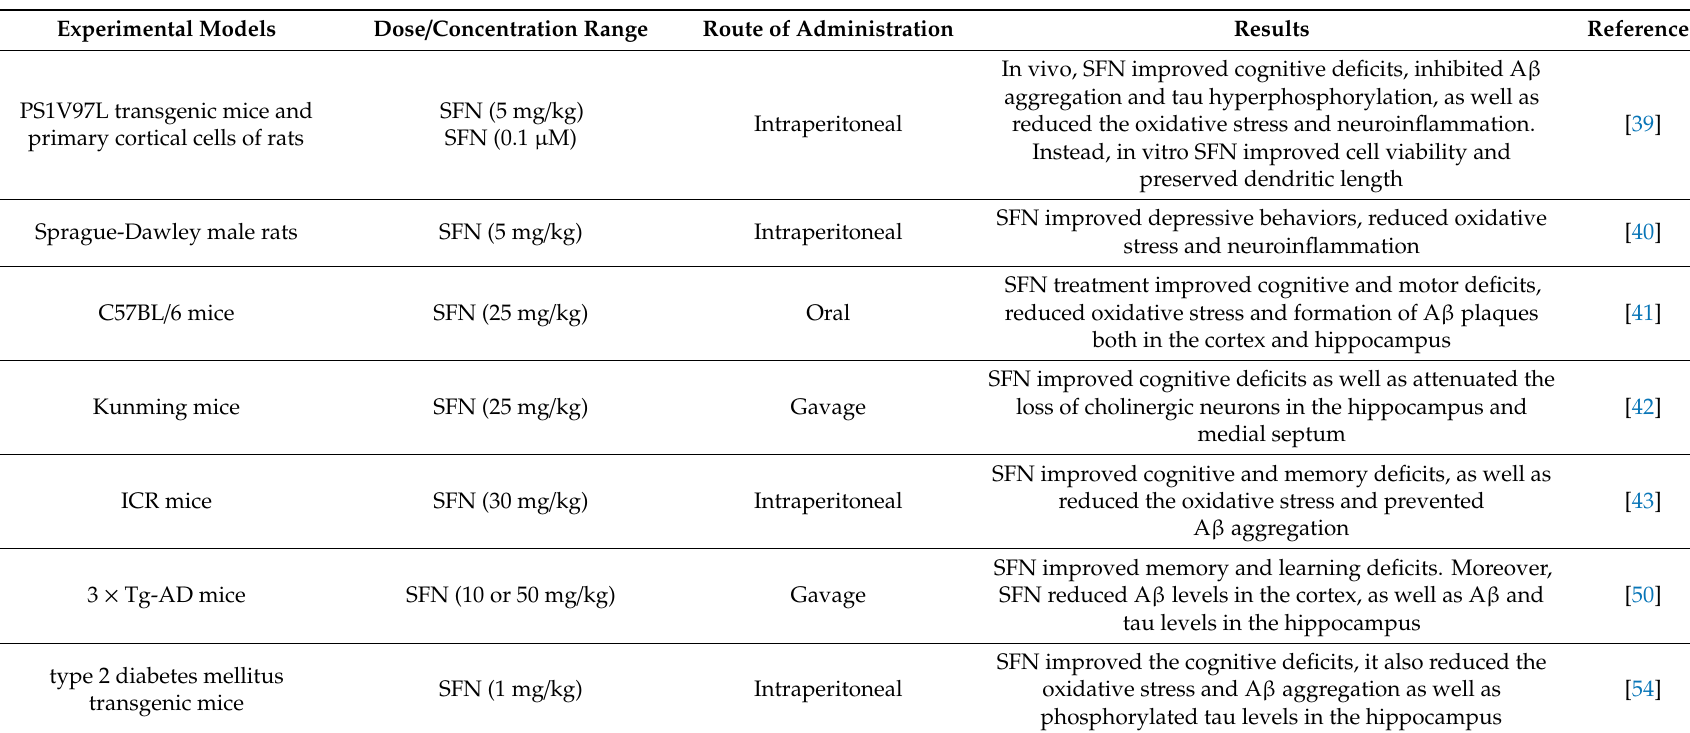
Table 1. Synthesis of the in vivo studies that evaluate the e ff ects of sulforaphane (SFN) in the treatment of AD. Specifically, the table describes the models used, the type of treatment, the dosage, and the results